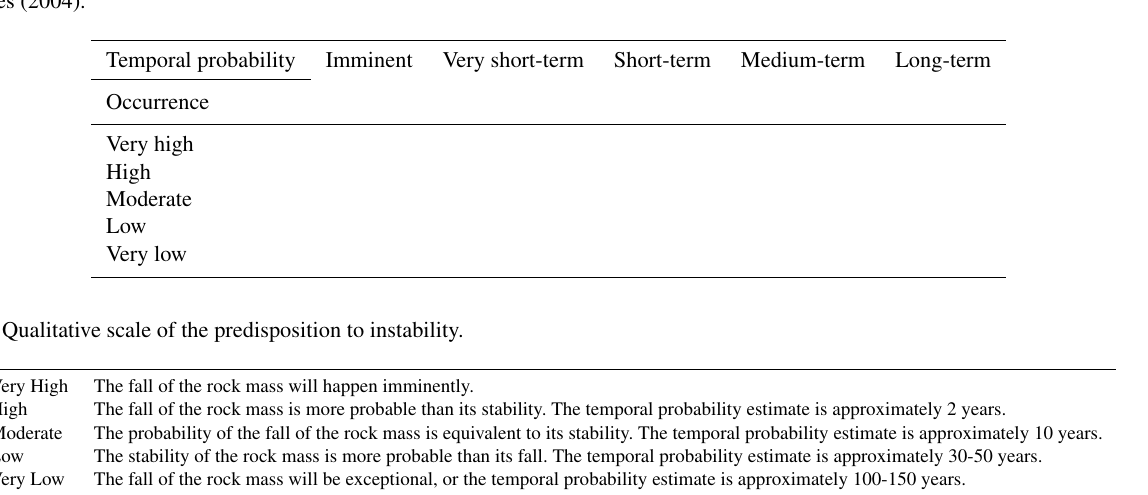
Table 3. Matrix used to assess the coupled “temporal probability/occurrence probability”, after the guide of the Laboratoire des Ponts et Chaussées (2004).